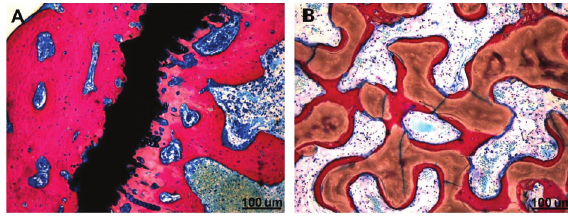
Figure 5. There was obvious new bone formation in the hard- tissue sections of the magnesium scaffold and surrounding tissue 3 months post-operation ( A ). There was no obvious new bone formation in the hard-tissue sections of the hydroxyapatite scaffold and surrounding tissue 3 months post-operation ( B ). Methylene blue-magenta staining (100 6